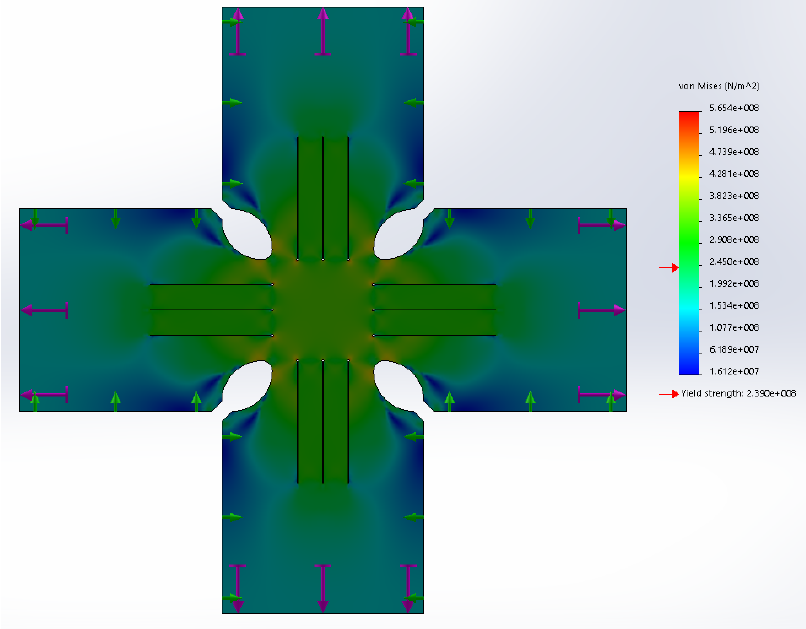
Figure 26. Typical stress distributions for the force ratio Fx:Fy = 1 using the von Mises condition of plasticity in the final step of the simulation. Purple arrows show the direction of the load; green arrows show the virtual action of the slider.